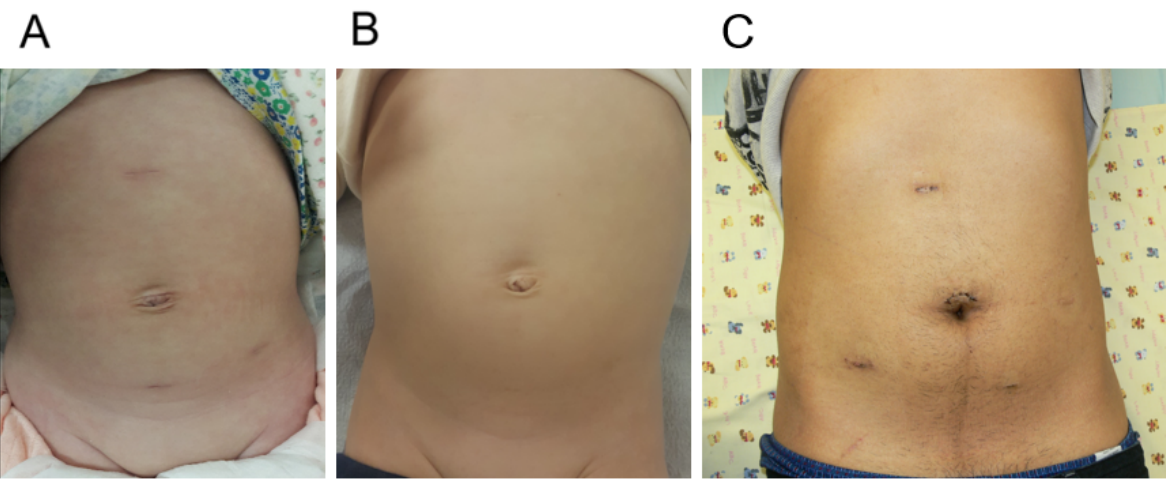
Figure 4. Cosmetic outcomes of robot-assisted laparoscopic pyeloplasty. One month after surgery in infant ( A ) and one year after surgery in infant ( B ). One month after surgery in adult ( C ).